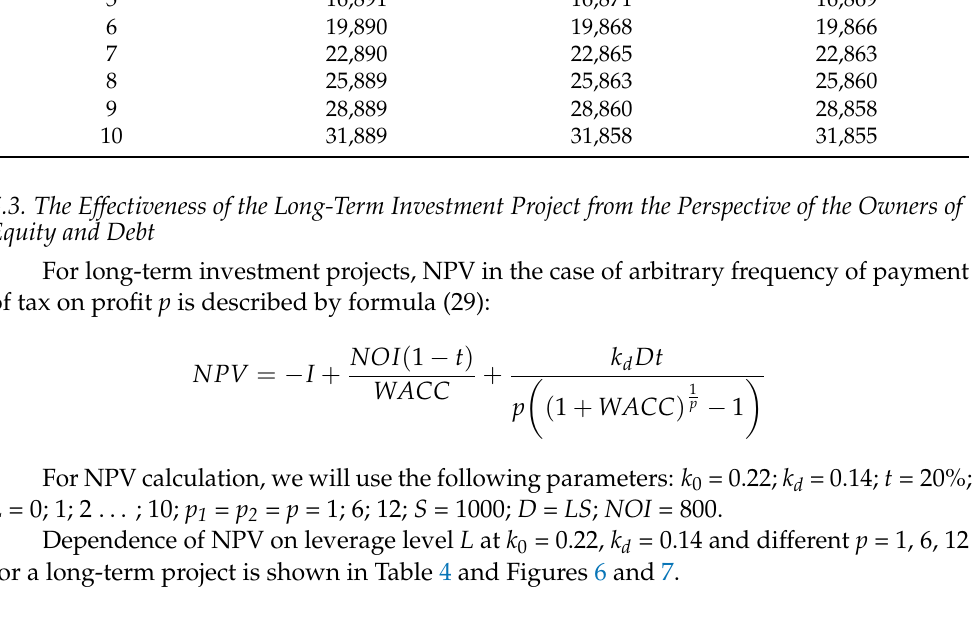
Table 4. Dependence of NPV on leverage level L at k 0 = 0.22, k d = 0.14 and different p = 1, 6,